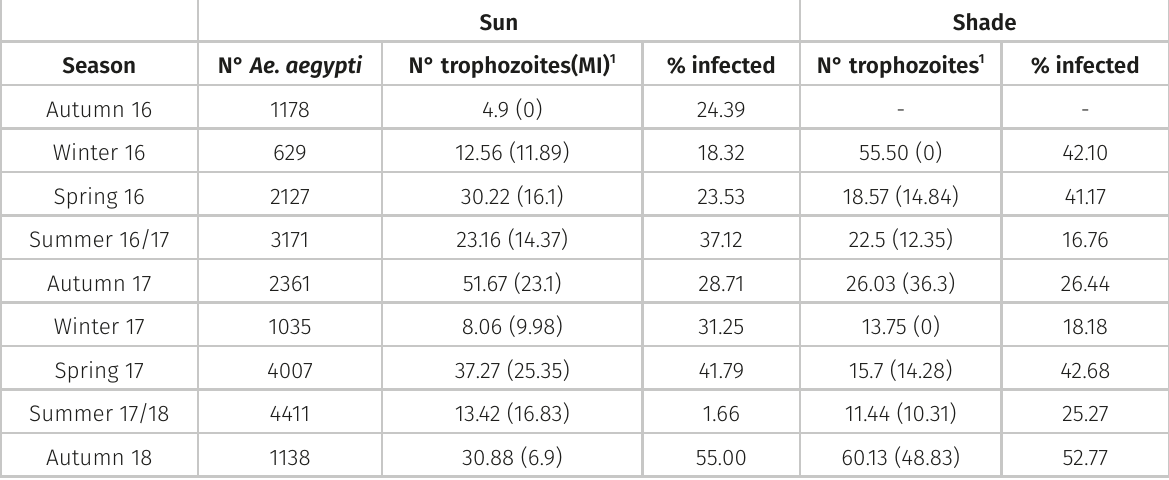
Table I. Seasonal infection rates and number of trophozoites of Ascogregarina culicis in natural populations of Aedes aegypti